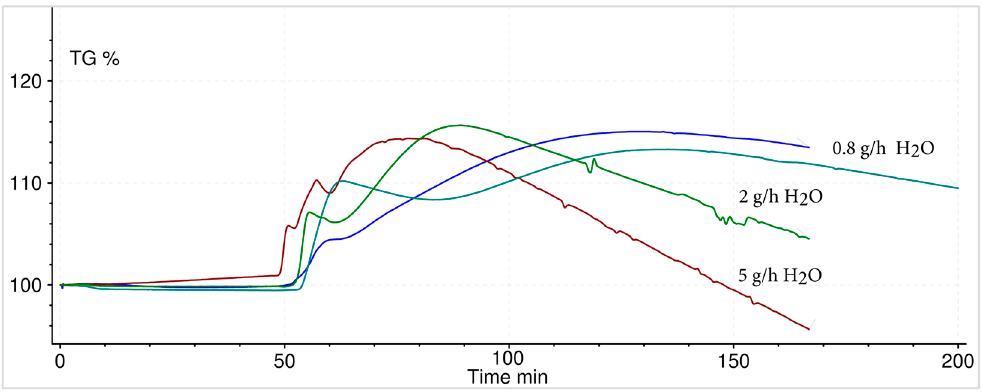
Figure 9. Hydration of 10 mg B 2 O 3 at constant temperature of 150 ◦ C—volatility of the resulting H 3 BO 3 depending on various water vapour mass flows.